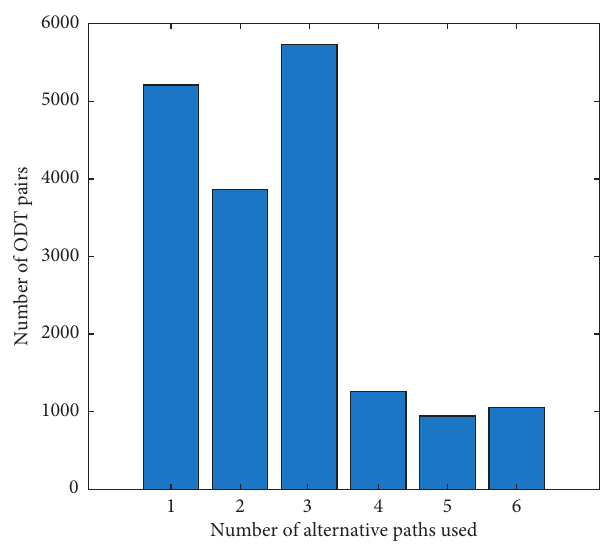
Figure 3: Distribution of the number of DUE paths used by ve- hicles. X -axis represents unique number of alternative paths used by the DUE in the simulation for different ODT pairs. Y -axis represents the number of ODTpairs. The majority of the simulated vehicles follow 3 or fewer